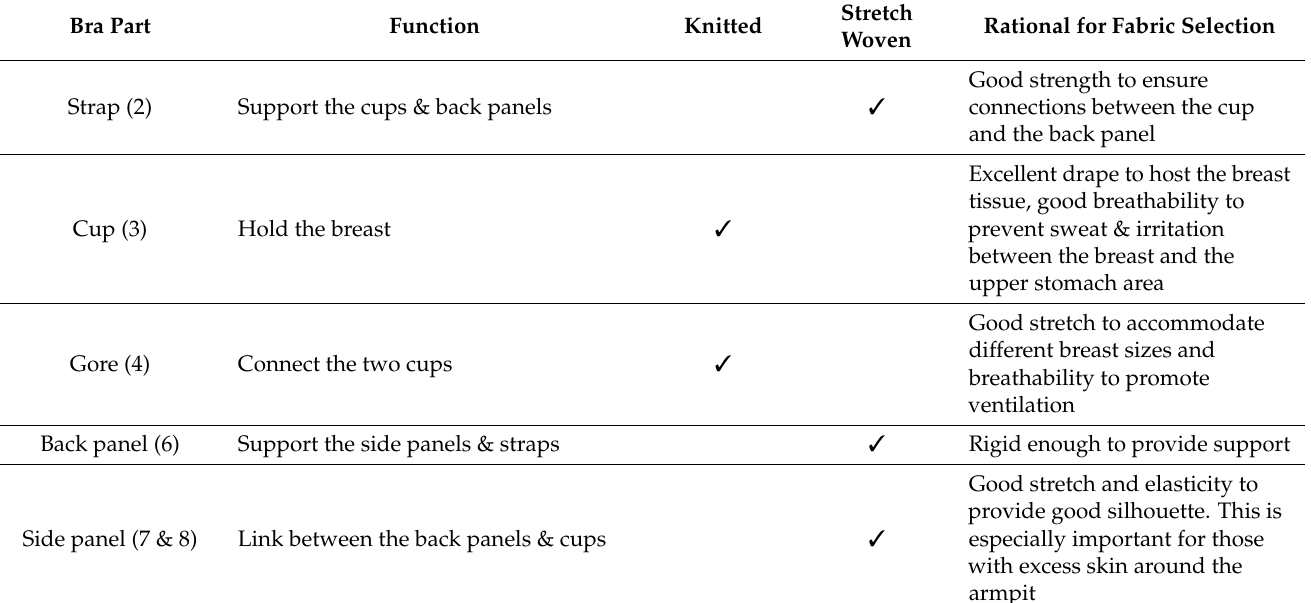
Table 2. Different bra parts, their function, most suited fabric type, and rational for the fabric selection.